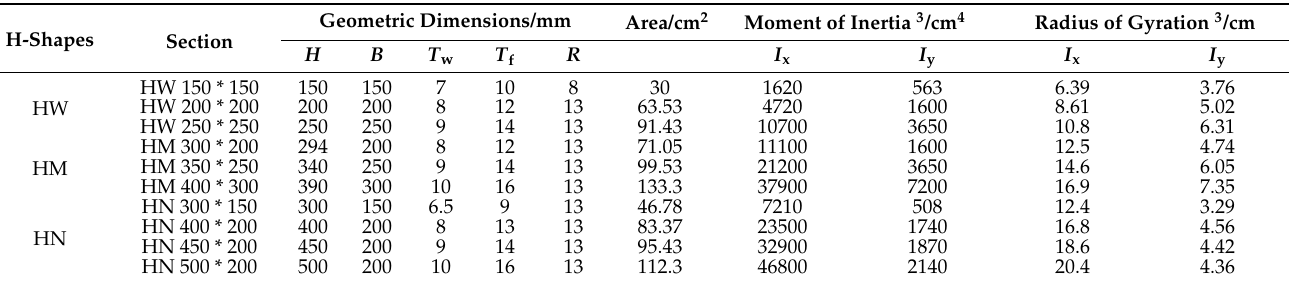
Table 3. Hot-rolled H-shapes for specimens (selected from GB/T 11263-2017 [2]).